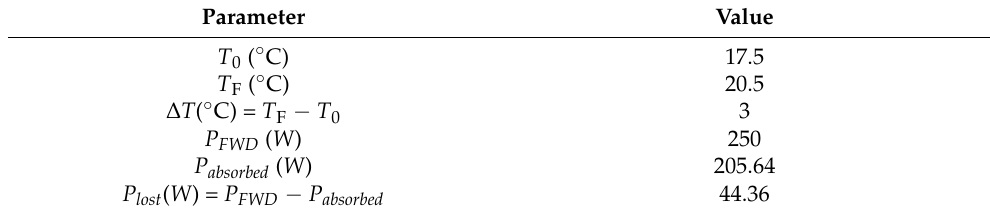
Table 2. Power measurements of the 2-liter